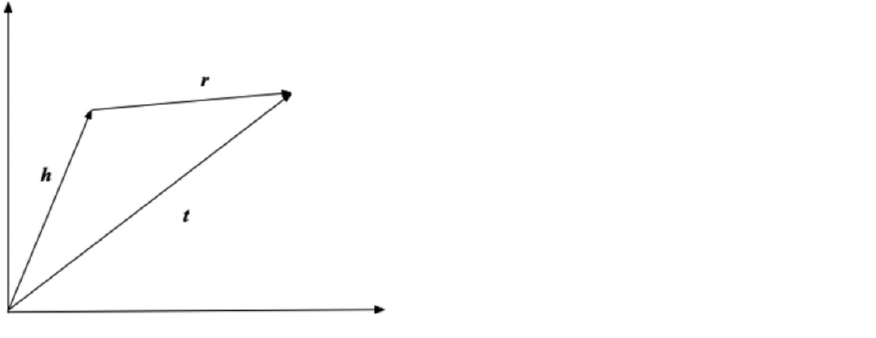
Figure 7. Simple illustration of TransE. The h, r, and t represent head, relationship, and tail in the triplet,